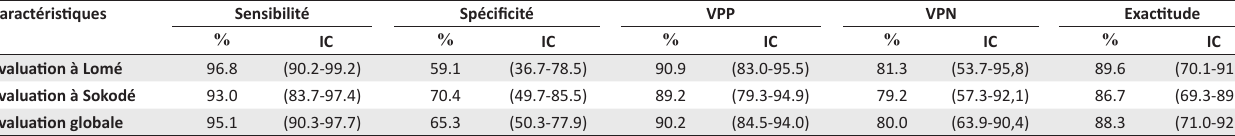
TABLEAU 4 : Évaluation de la performance intrinsèque et extrinsèque de l’Hemocue Hb 201+ ® . Caractéristiques